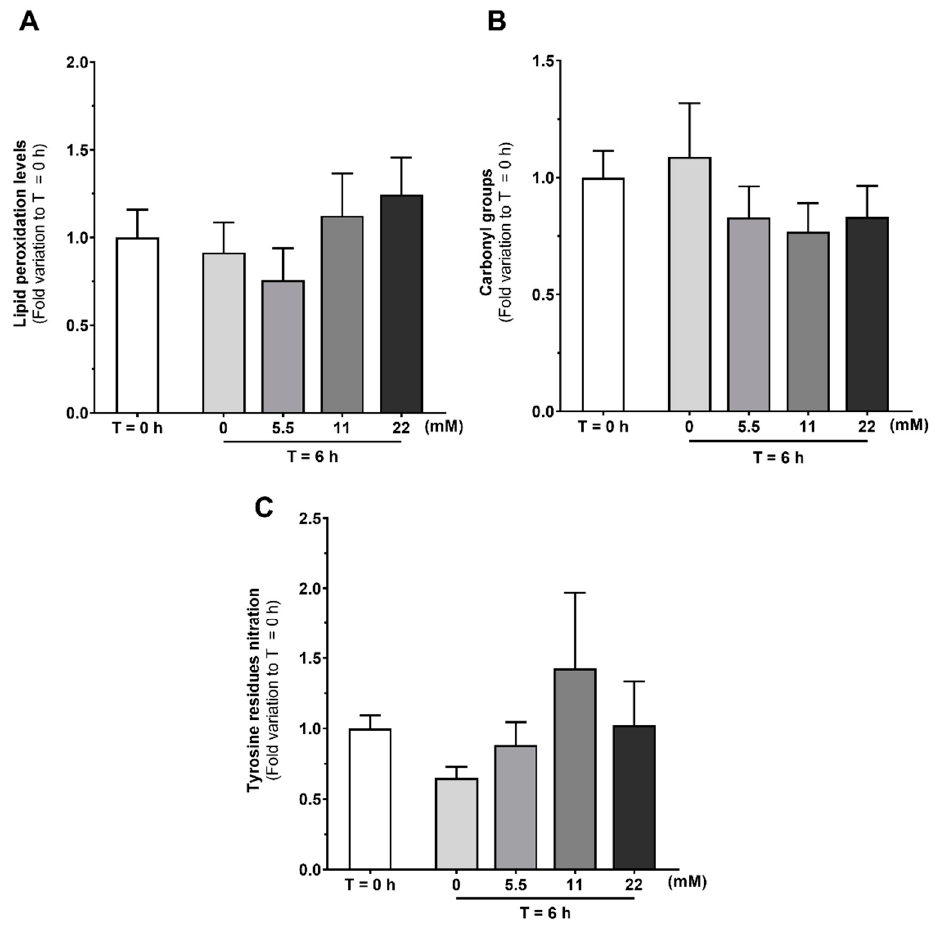
Figure 7. Oxidative stress-induced damage in human spermatozoa at baseline (T = 0 h) and after 6 h incubation without or with glucose (0, 5.5, 11, and 22 mM) under capacitation conditions on lipid peroxidation ( A ), carbonyl group formation ( B ), and tyrosine residues nitration ( C ) in human spermatozoa. Results are expressed as mean ± SEM (( A , B ) n = 15 for each condition, ( C ) n = 8 for each condition).